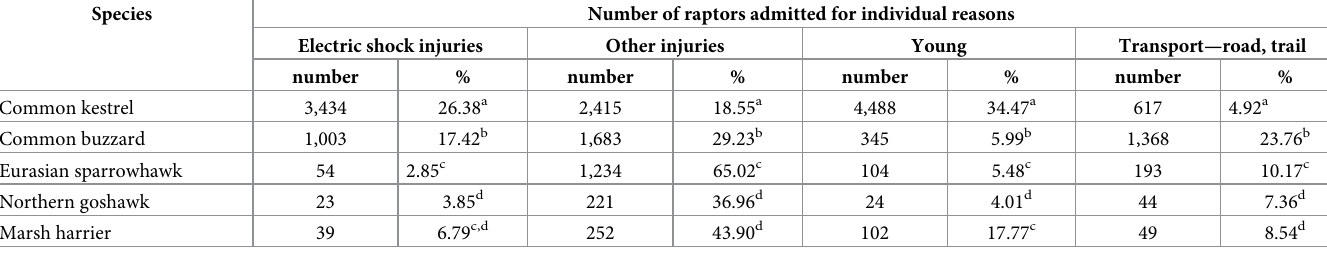
Table 5. Number of birds admitted for selected (most frequent) reasons in the most common raptor species. Species Number of raptors admitted for individual reasons Electric shock injuries Other injuries Young Transport—road, trail number % number % number % number % Common kestrel Common buzzard Eurasian sparrowhawk Northern goshawk Marsh